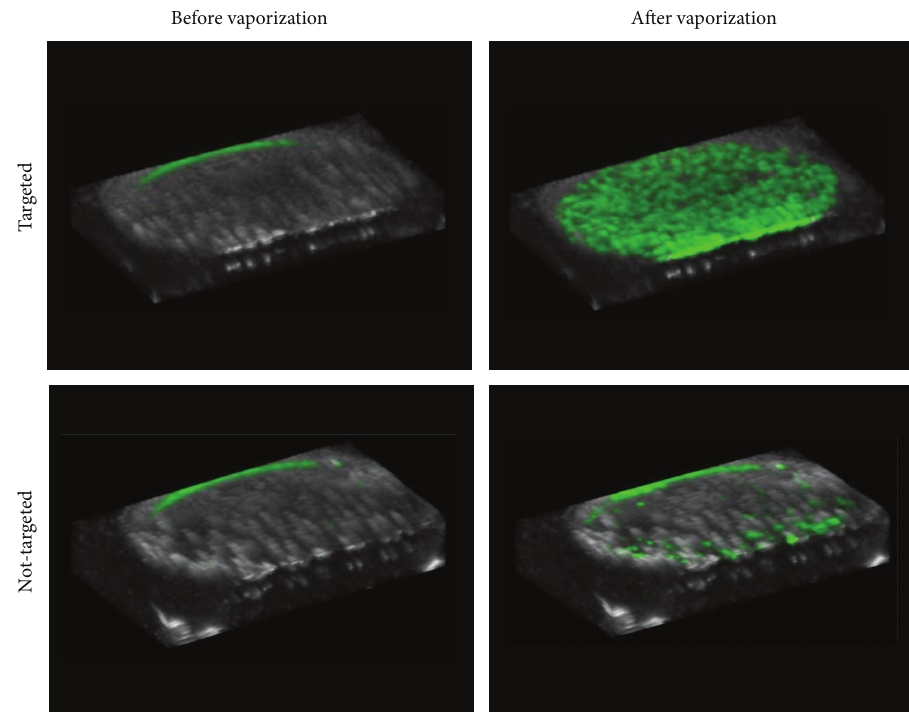
Figure 10: Overlays of contrast-specific CPS intensity (green scale) and traditional B-mode (grey scale) ultrasound scans: 3-D rendering of the ultrasound slices across the cell sample volume reveals the contrast enhancement provided by targeted PCAs after the activation pulse. Non-targeted samples resulted in a small amount of contrast enhancement, likely as a result of non-selective binding. The small amount of contrast present at the top of each sample is an artifact of the metal holder, not a result of the presence of echogenic bubbles. Reprinted from [99], Copyright 2013, with permission from